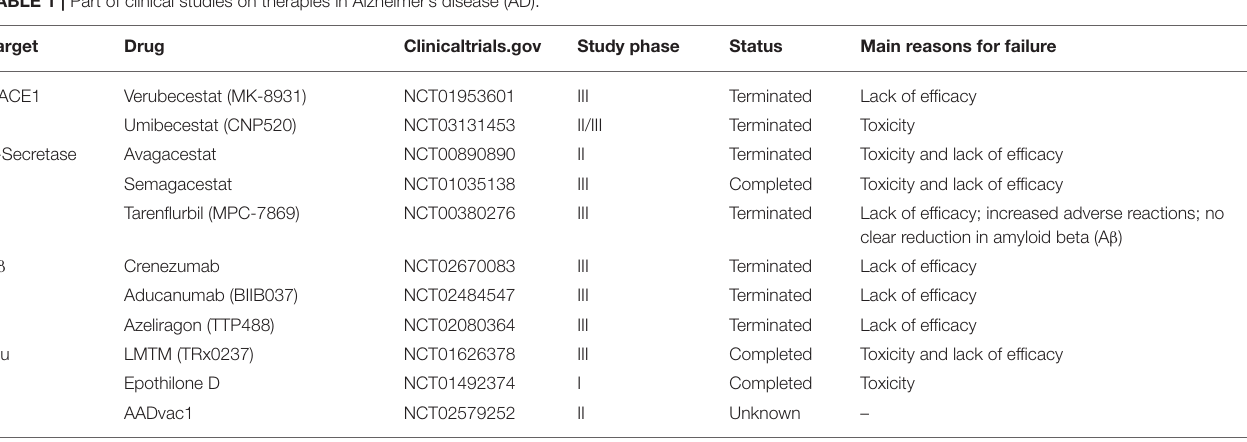
TABLE 1 | Part of clinical studies on therapies in Alzheimer’s disease (AD).